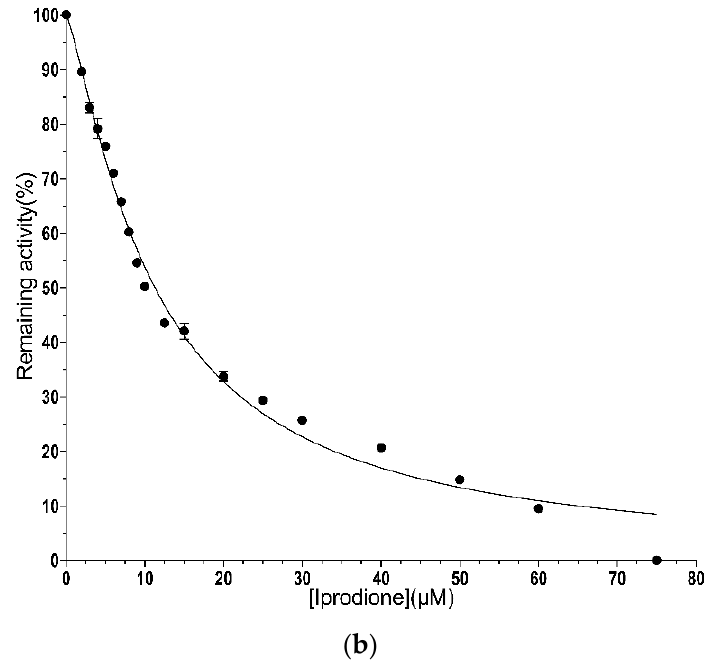
Figure 3. ( a ) The 2D structure of iprodione (C 13 H 13 Cl 2 N 3 O 3 ). ( b ) Concentration – response curve for iprodione. The IC 50 for Mm GSTP1 − 1 was determined by fitting Equation (2) to the data using non-linear curve-fitting methods.